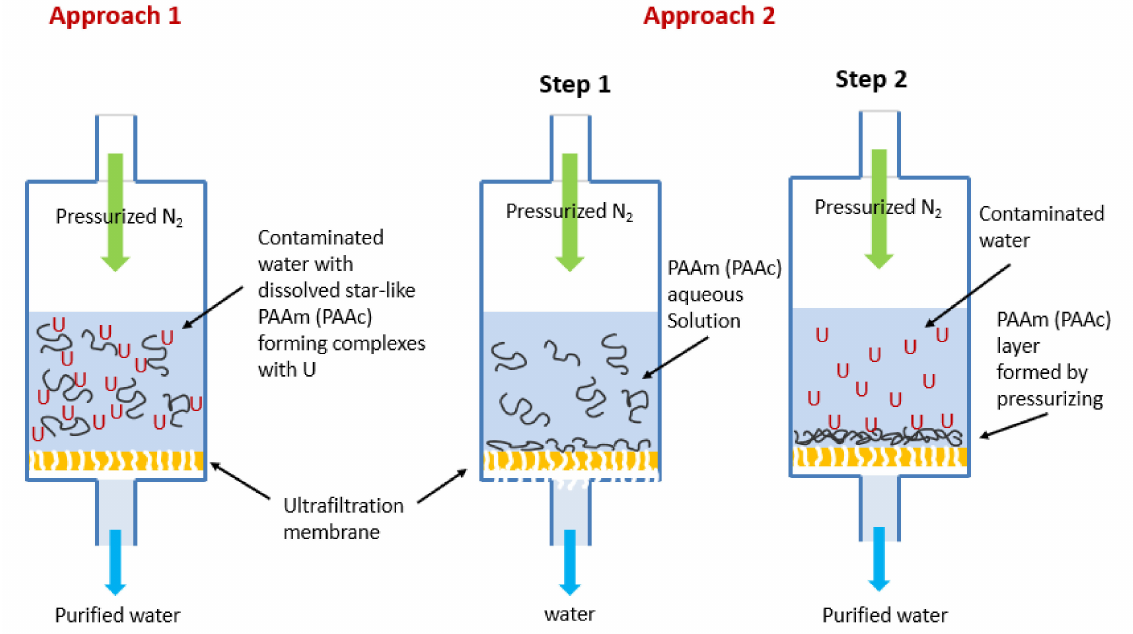
Figure 2. Two possible strategies for adsorption/filtration of radionuclides using a combination of water-soluble polymers and UF